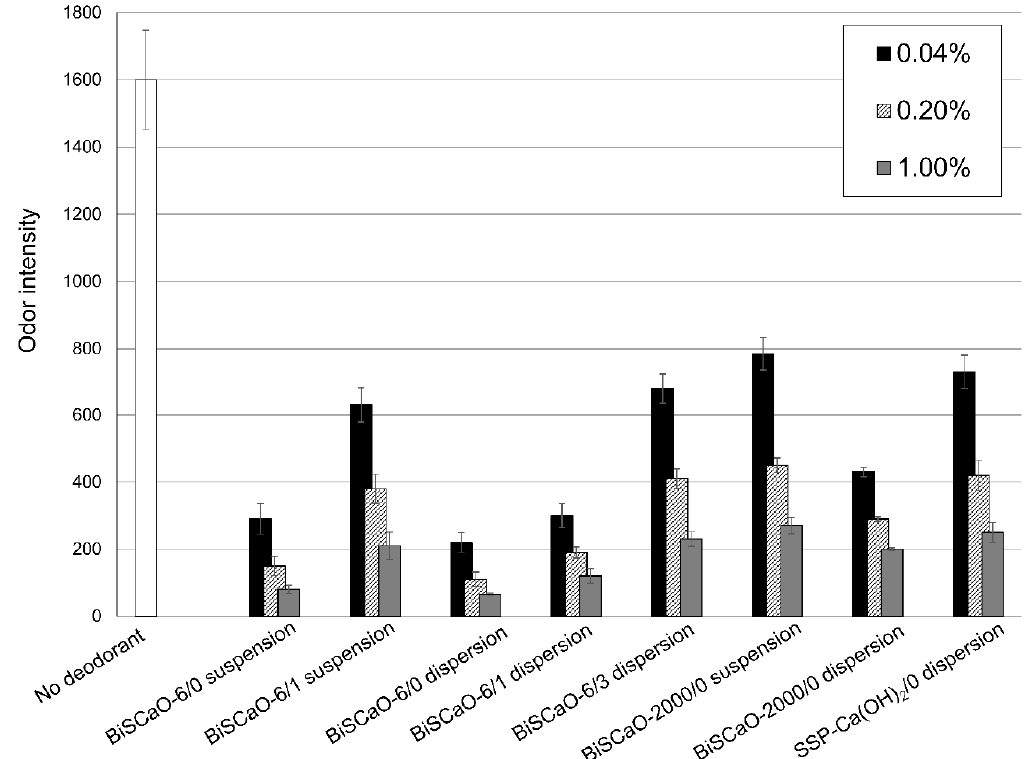
Figure 4. Efficacy of BiSCaO suspensions and dispersions for deodorizing contaminated minced pork. The indicated concentration and time after adjustment (/0: immediately after adjustment, /1: one day after adjustment, /3: three days after adjustment) of each BiSCaO suspension or dispersion was added to tainted pork meat on a petri dish, then sealed in a plastic bag for 1 h. The odor intensity was then measured using a handheld odor meter. The experiments were repeated three times and all provided results identical to the results shown.